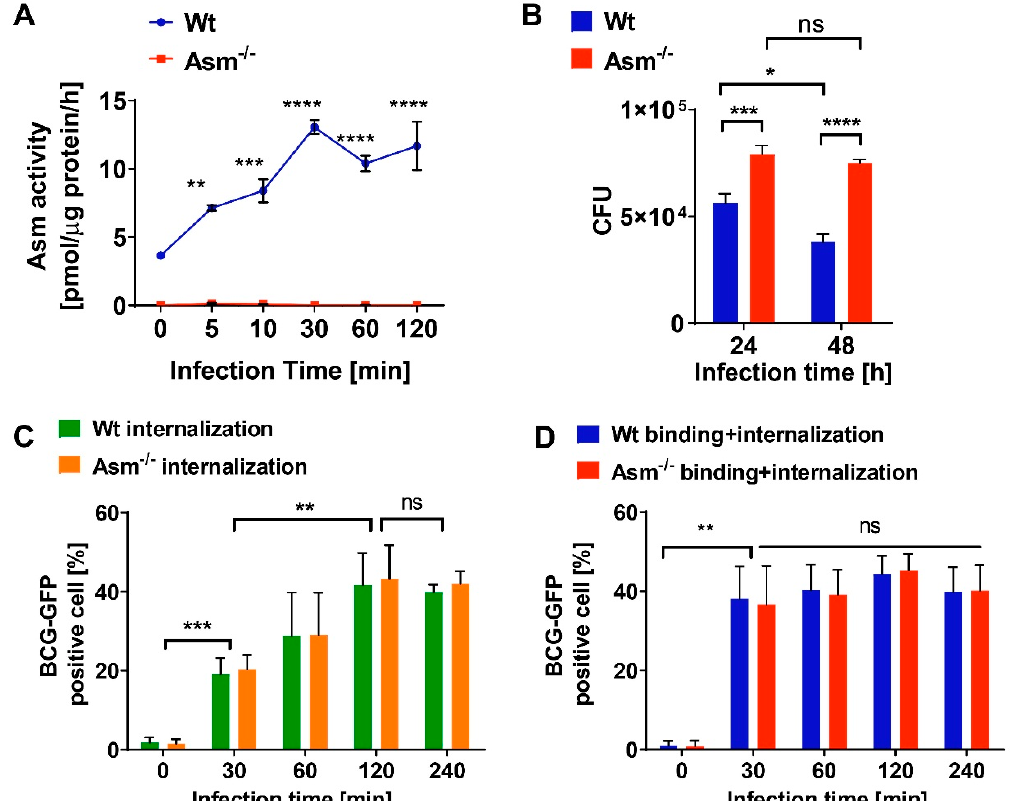
Figure 2. Acid sphingomyelinase deficiency impairs BCG killing but not internalization by macrophages. Bone-marrow-derived macrophages from wild-type and acid-sphingomyelinase-deficient (Asm − / − ) mice were infected with GFP-BCG for the indicated time and ( A ) Asm activity and ( B ) colony-forming unit (CFU) assays were performed. ( C ) Bacterial internalization and ( D ) binding + internalization were investigated by flow cytometry of 10,000 cells/sample, with noninfected cells used as control. Shown are means ± SD, n = 3, ANOVA from 3 independent experiments, **** p < 0.0001, *** p < 0.001, ** p < 0.01, * p < 0.05. ns = no significant.